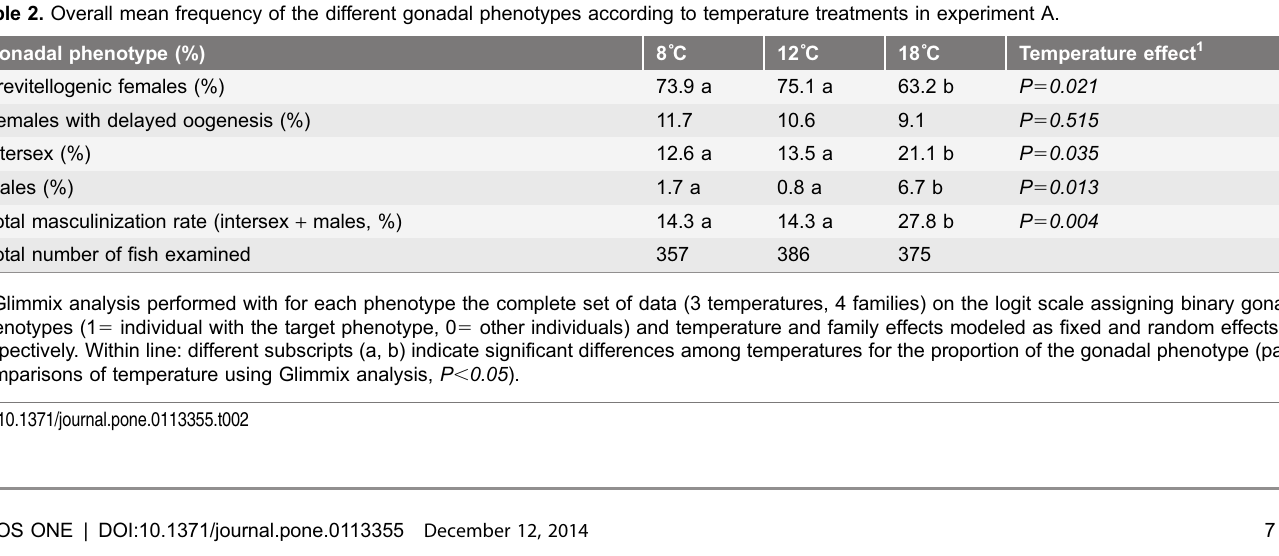
Table 2. Overall mean frequency of the different gonadal phenotypes according to temperature treatments in experiment A. Gonadal phenotype (%) Previtellogenic females (%)